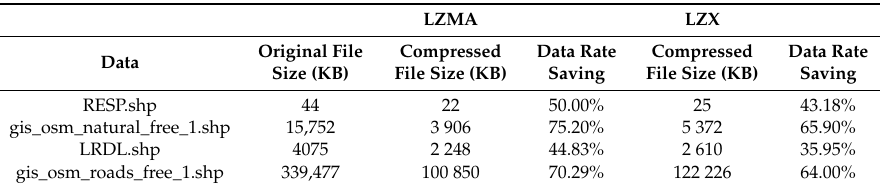
Table 6. Lossless compression results of four test datasets.